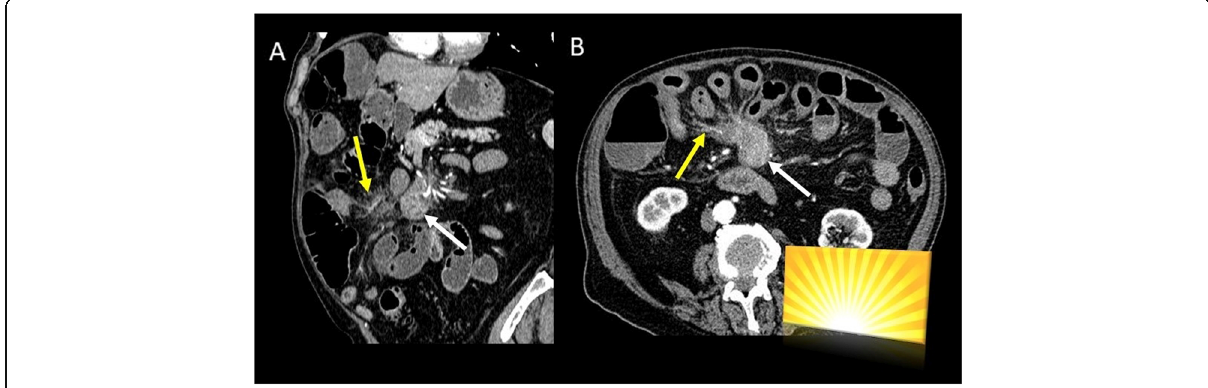
Fig. 12 Mesenteric carcinoid tumor. CT images (( a ) coronal and ( b ) axial plane) show hypervascular mesenteric mass (white arrow) with intralesional calcification and an intense fibrotic proliferation (yellow arrow), the so-called spoke-wheel or sunburst